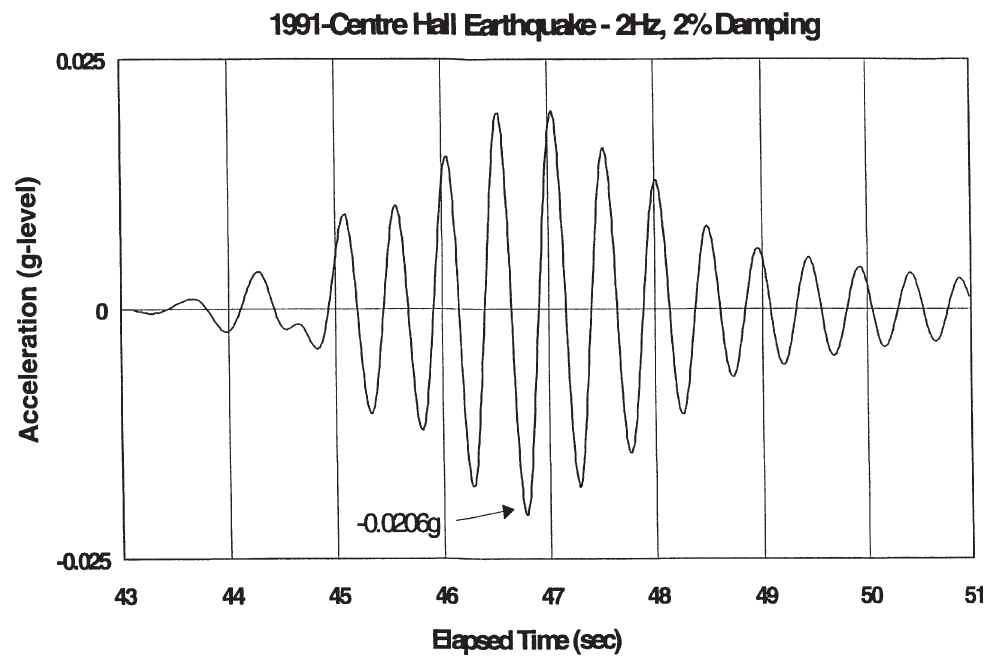
Fig. 4. Acceleration (g-level) time-history-response at Centre Hall station during the 1991 Centre Hall earthquake in Central